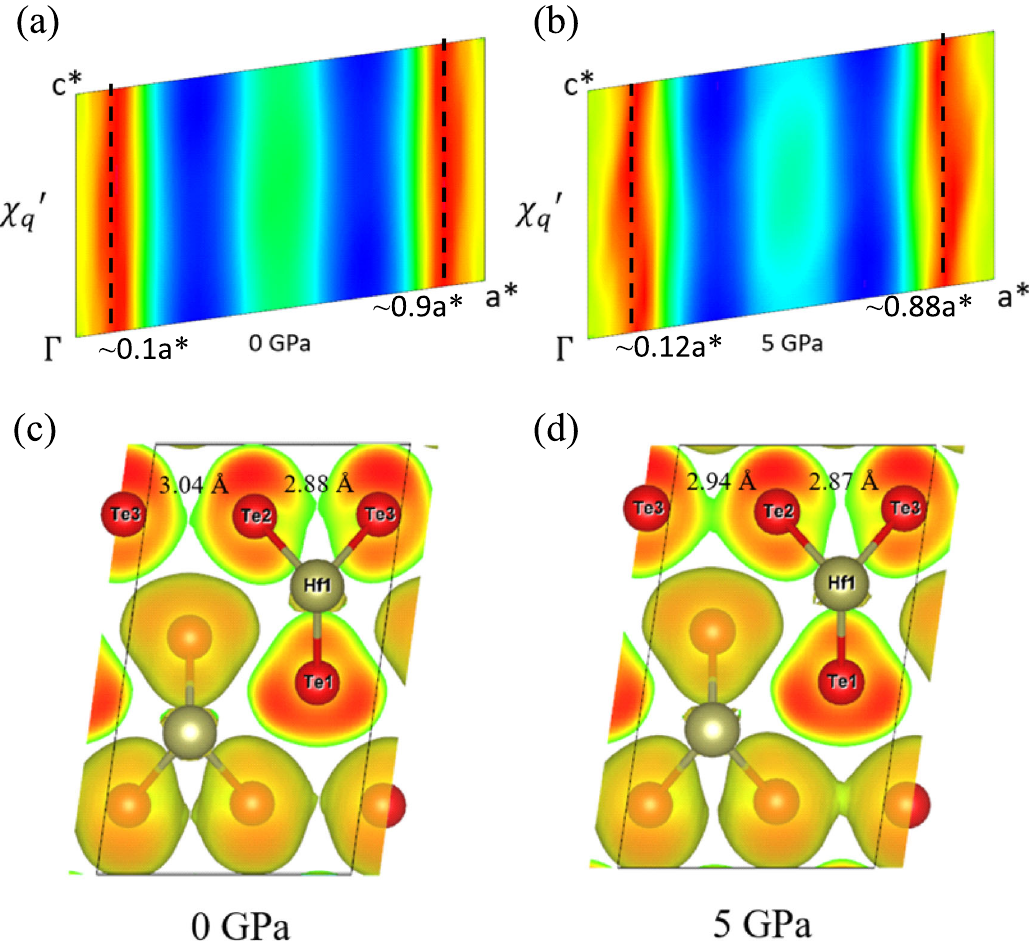
Fig. 9 The calculated electronic susceptibility and localization function of HfTe 3 . The calculated real part of the electronic susceptibility χ q ′ for HfTe 3 in the a *- c * plane at a 0 GPa and b 5 GPa. The components along the b * direction have been integrated. The calculated electronic localization function of HfTe 3 at c 0 GPa and d 5 GPa. The isosurface was set as